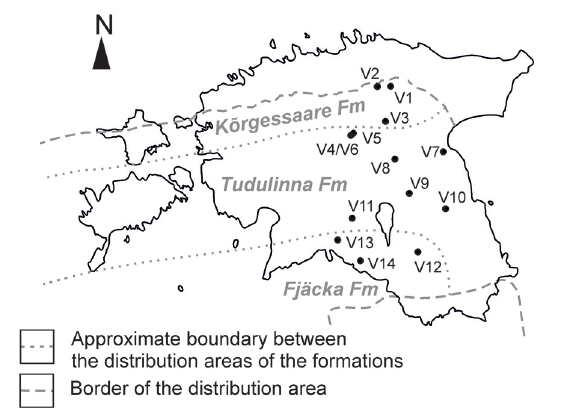
Fig. 6. Distribution of the Vormsi RS and the location